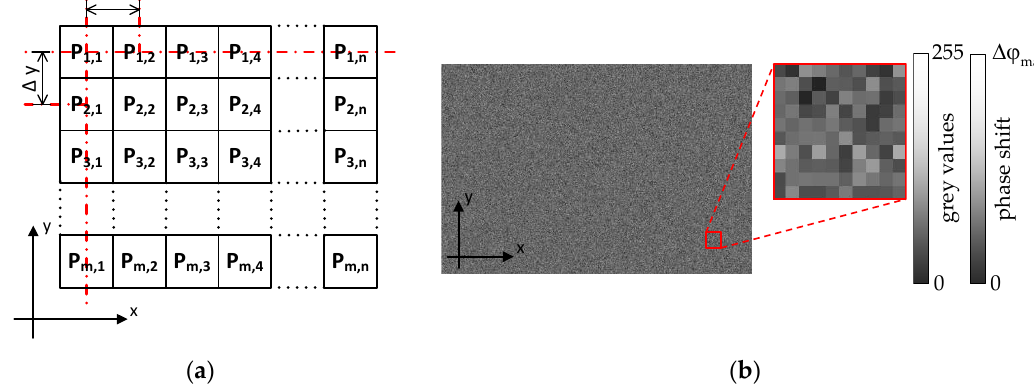
Figure 3. Schematic principle of the phase modulation by the liquid-crystal-based spatial light modulator (LCSLM). ( a ) Pixel structure and ( b ) phase mask corresponding to a roughness of R = 115nm.